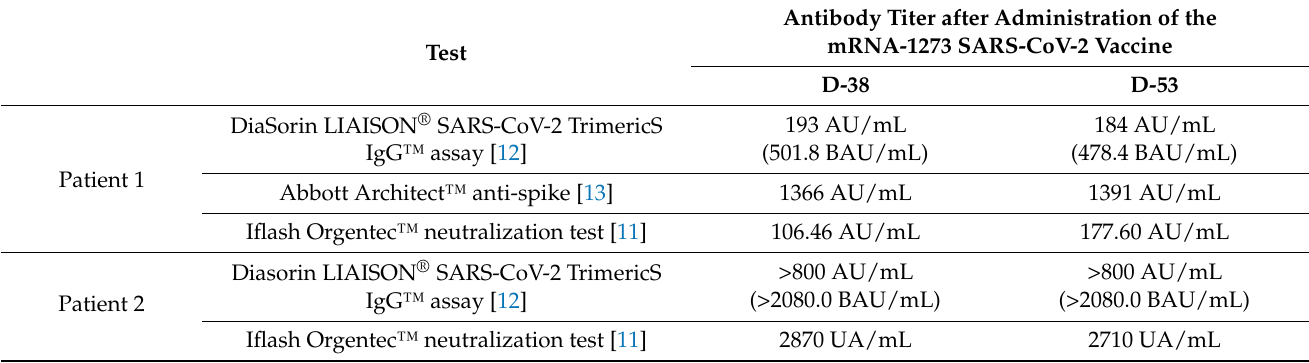
Table 2. Antibody responses after the first (D-38) and the second (D-53) dose of mRNA-1273 SARS-CoV-2